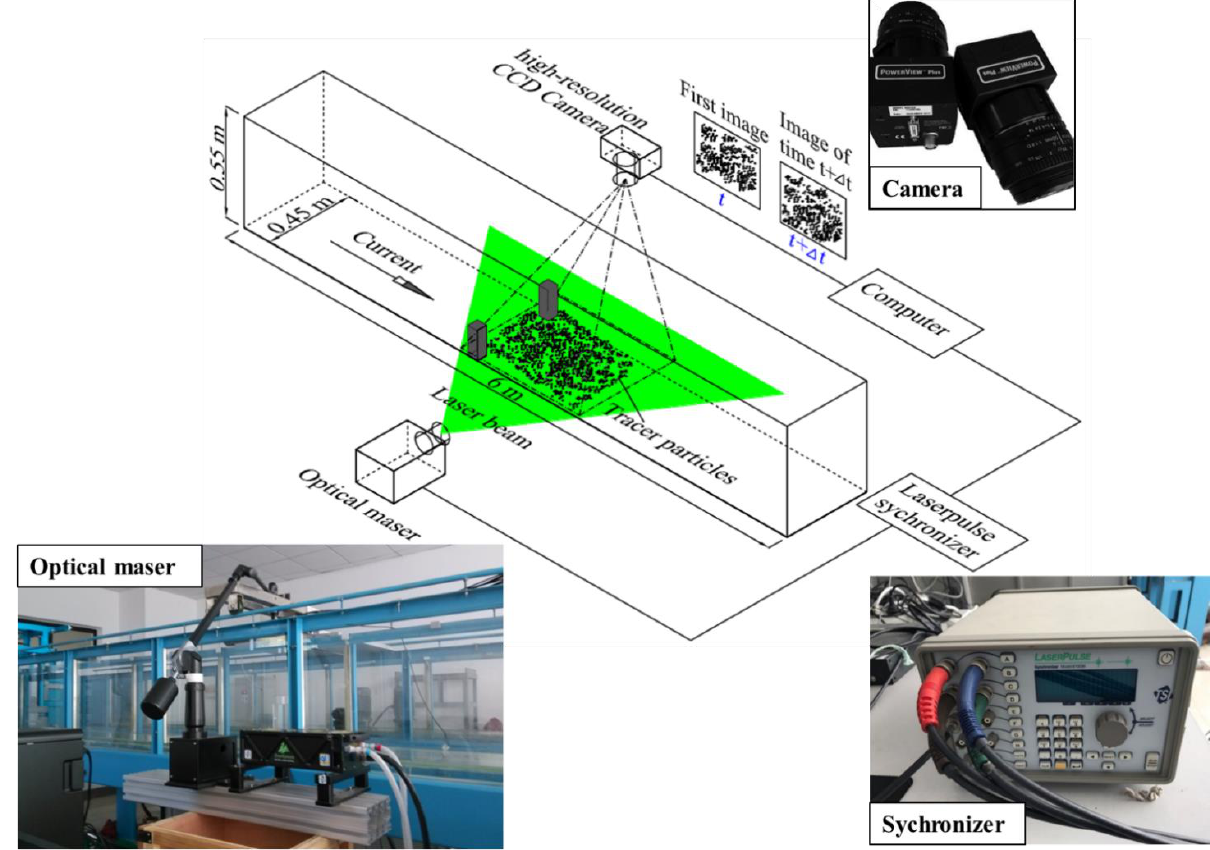
Figure 2. The diagram of flume and Particle Image Velocimetry (PIV) test stand with two symmetrical groins (black rectangular blocks).